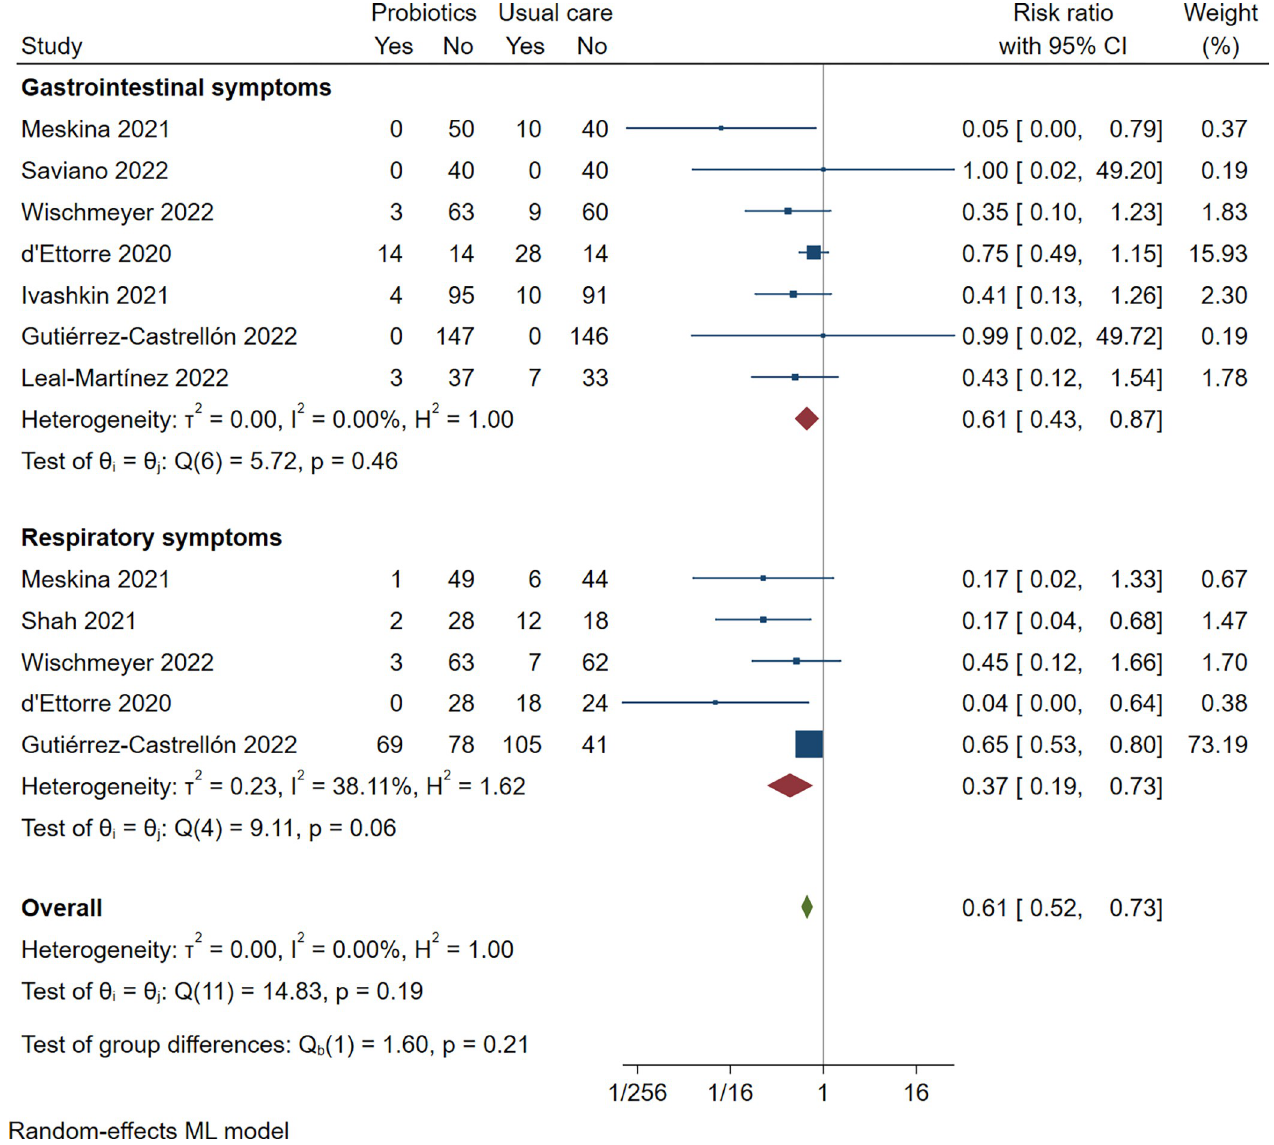
Fig 3. Gastrointestinal and respiratory